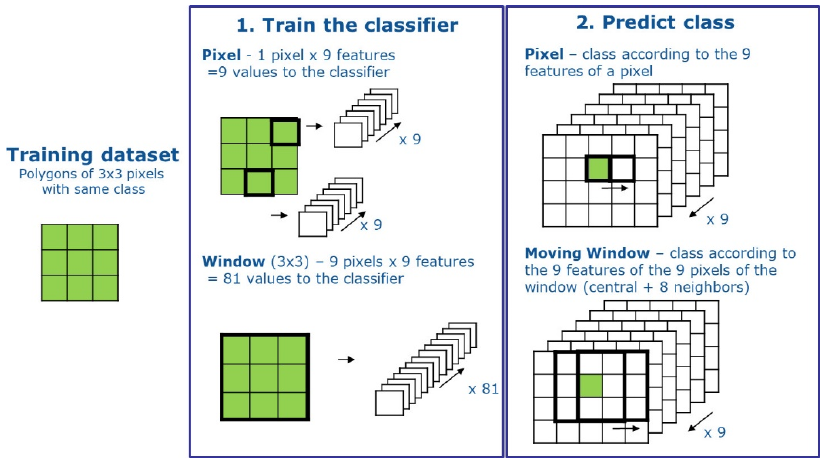
Figure 7. “pixel” and “window” classification